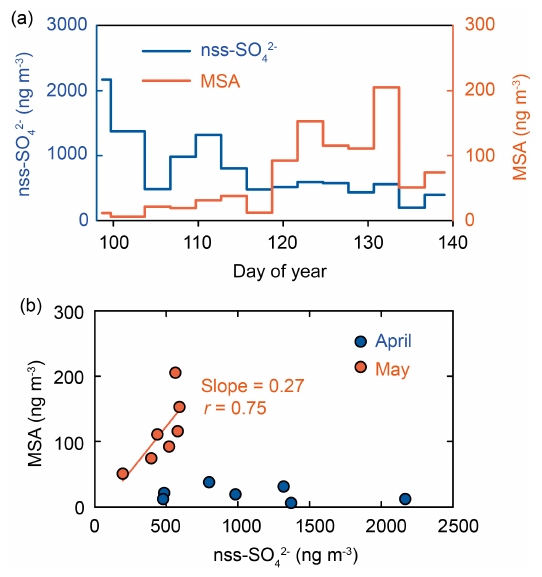
Figure 4. Relation between the nss-SO 2 − MSA concentration (PM 2 . 5 ; April and May 2015; gray circles). The dashed line indicates the bio-SO 2 − Ålesund in 2014 (Udisti et al.,